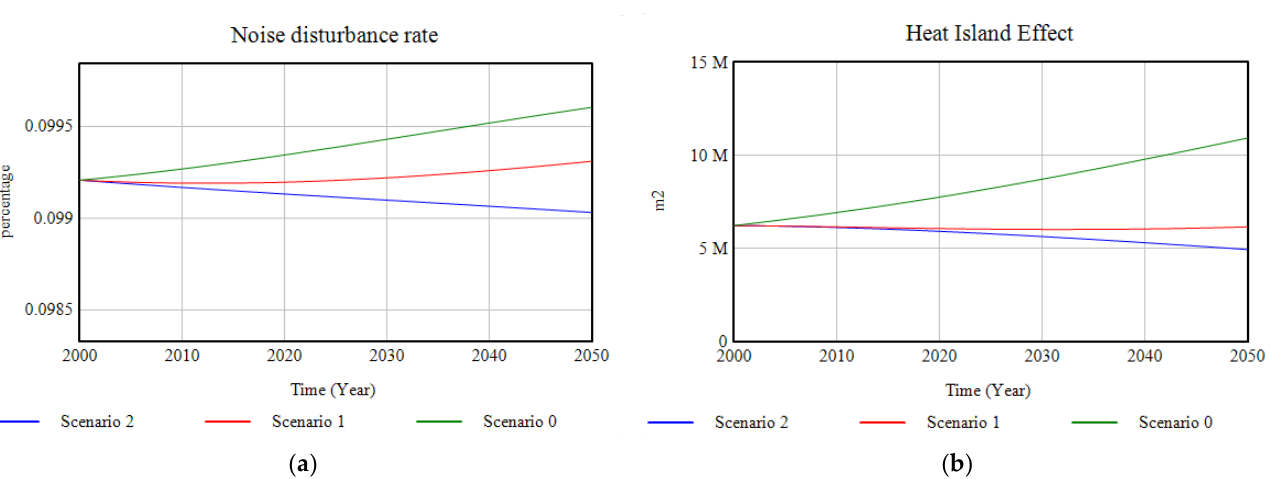
Table 3. Numerical results of investment values and adjusted GDP variation for Scenario 1.